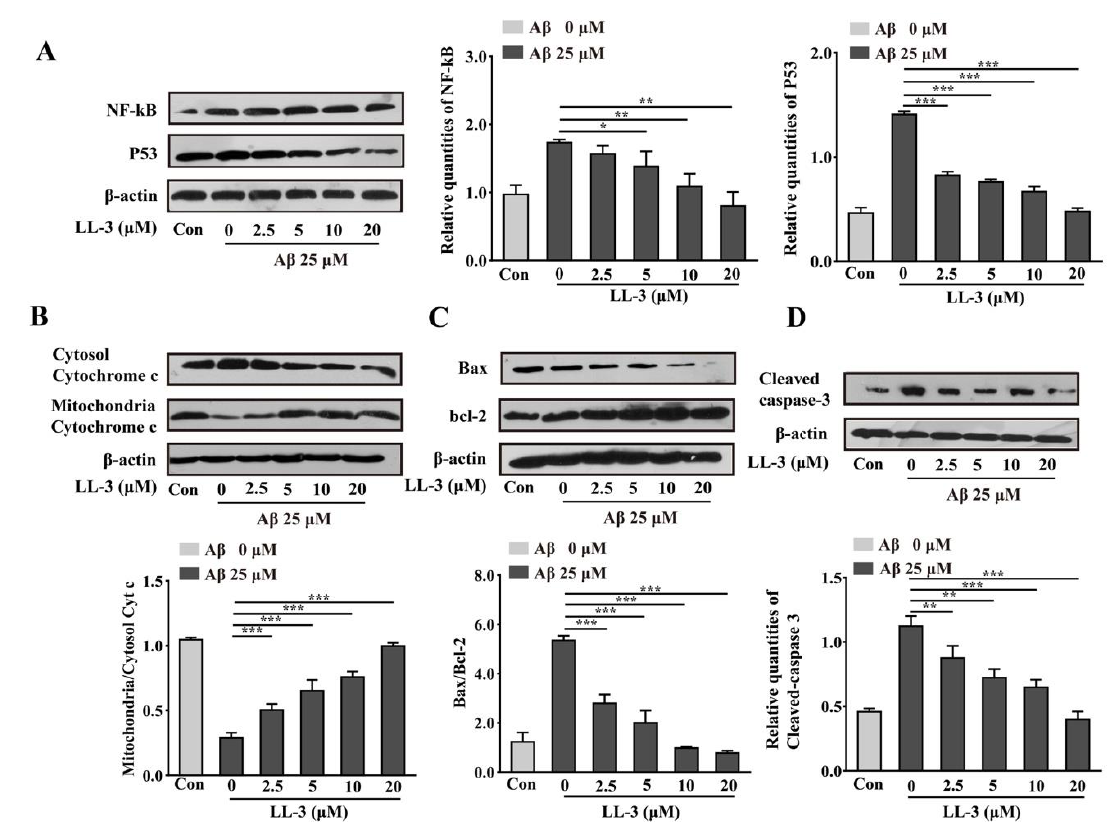
Figure 6. E ff ect of LL-3 on expressions of NF- κ B, p53, bcl-2, Bax, Cytochrome C, and Cleaved-caspase 3 protein through A β 25-35 -induced SH-SY5Y cells. Di ff erent concentrations of LL-3 were added in cells for 30 min prior to 25 µ M A β with 48 h. Representative image of western blots of NF- κ B, p53 protein ( A ), Cytosol Cytochrome c, Mitochondria Cytochrome c protein ( B ), bcl-2, Bax protein ( C ), Cleaved-caspase 3 protein ( D ). Densitometric analysis of respective changes in levels of values of NF- κ B, p53, ratio of Cytosol Cytochrome c / Mitochondria Cytochrome c, ratio of Bcl-2 / Bax, and Cleaved-caspase 3. β -actin was used as the internal control. Data were mean ± SD, * p < 0.05, ** p < 0.01, and *** p < 0.001 compared to A β 25-35 alone.